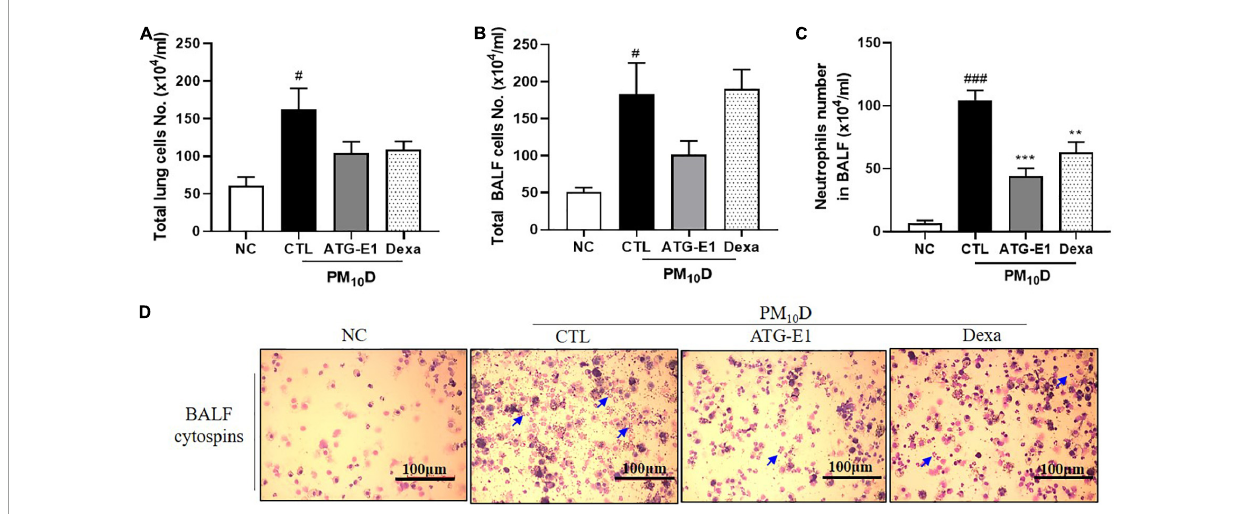
FIGURE2 Effects of L. paracasei ATG-E1 on cell numbers in a PM 10 D-induced airway inflammation animal. Total number of (A) lung cells, (B) BALF cells, (C) neutrophil number in BALF cytospins, and (D) photomicrograph of BALF cytospins. The data are presented as means ± SEM ( n = 8). Blue arrow represents the neutrophils. # p < 0.05 and ### p < 0.005 vs. NC; ** p < 0.01 and *** p < 0.005 vs. CTL. NC: normal mice; CTL: PM 10 D-sensitized control mice; Dexa: 3 mg/kg dexamethasone-treated PM 10 D-sensitized mice; ATG-E1: 4 × 10 9 CFU/day of L. paracasei ATG-E1-treated PM 10 D-sensitized